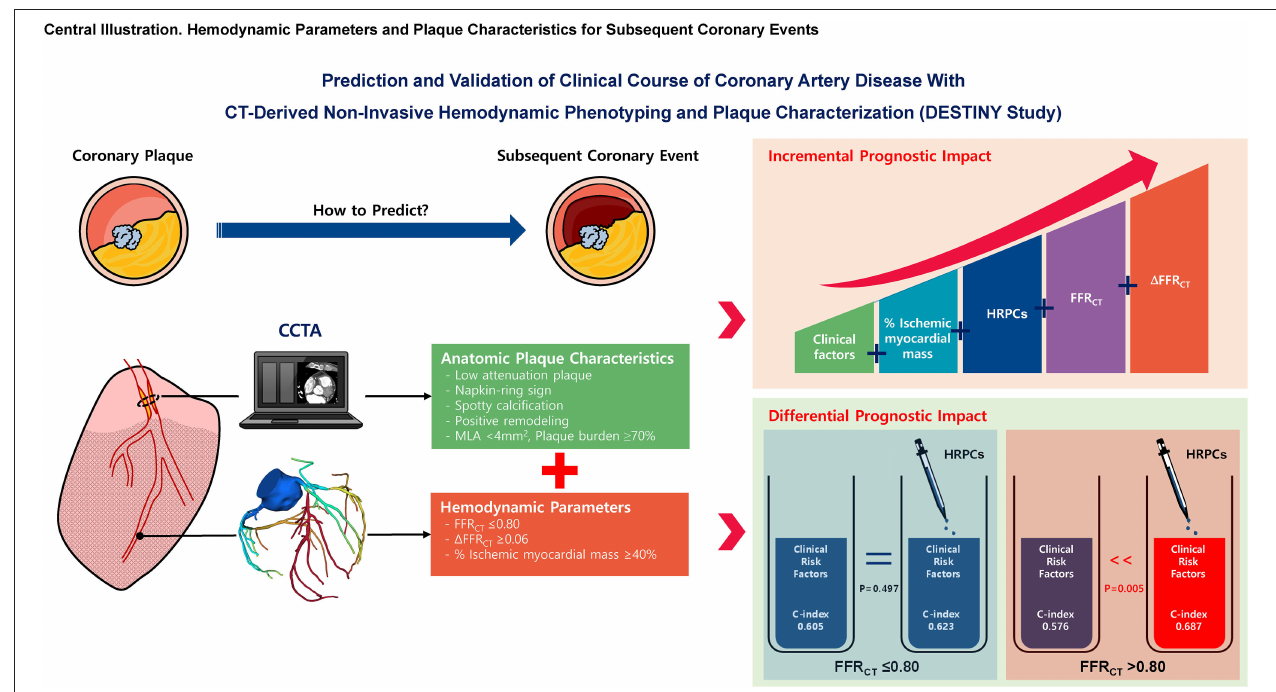
FIGURE 7 | Hemodynamic parameters and plaque characteristics for subsequent coronary events. This study evaluated the prognostic implications of CCTA-derived HRPCs and hemodynamic parameters in the prediction of subsequent coronary events. Compared with clinical risk factors, HRPCs and hemodynamic parameters showed higher discriminant abilities for subsequent coronary events. HRPCs showed an additive discriminant ability to clinical risk factors, and hemodynamic parameters further increased discriminant ability for subsequent coronary events. Among vessels with negative FFR CT ( > 0.80), adding HRPCs into clinical risk factors significantly increased discriminant and reclassification abilities for subsequent coronary events but not for vessels with positive FFR CT ( ≤ 0.80). These results imply that additional evaluation of CCTA-based anatomic plaque characteristics in hemodynamically insignificant lesions might improve risk stratification in patients with CAD. FFR CT , fractional flow reserve by coronary computed tomography angiography; HRPCs, high-risk plaque characteristics; MLA, minimum lumen